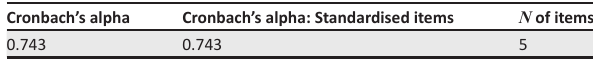
TABLE 1: Reliability statistics: Cronbach’s alpha for five-item construct.